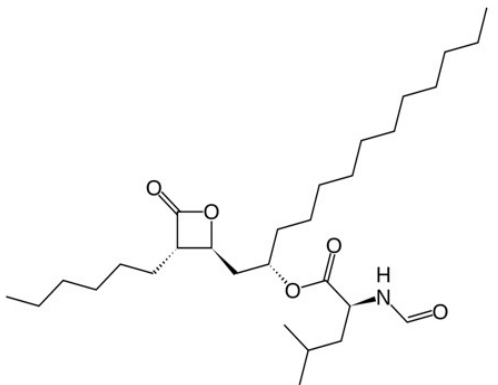
Figure 1. Chemical structure of orlistat.